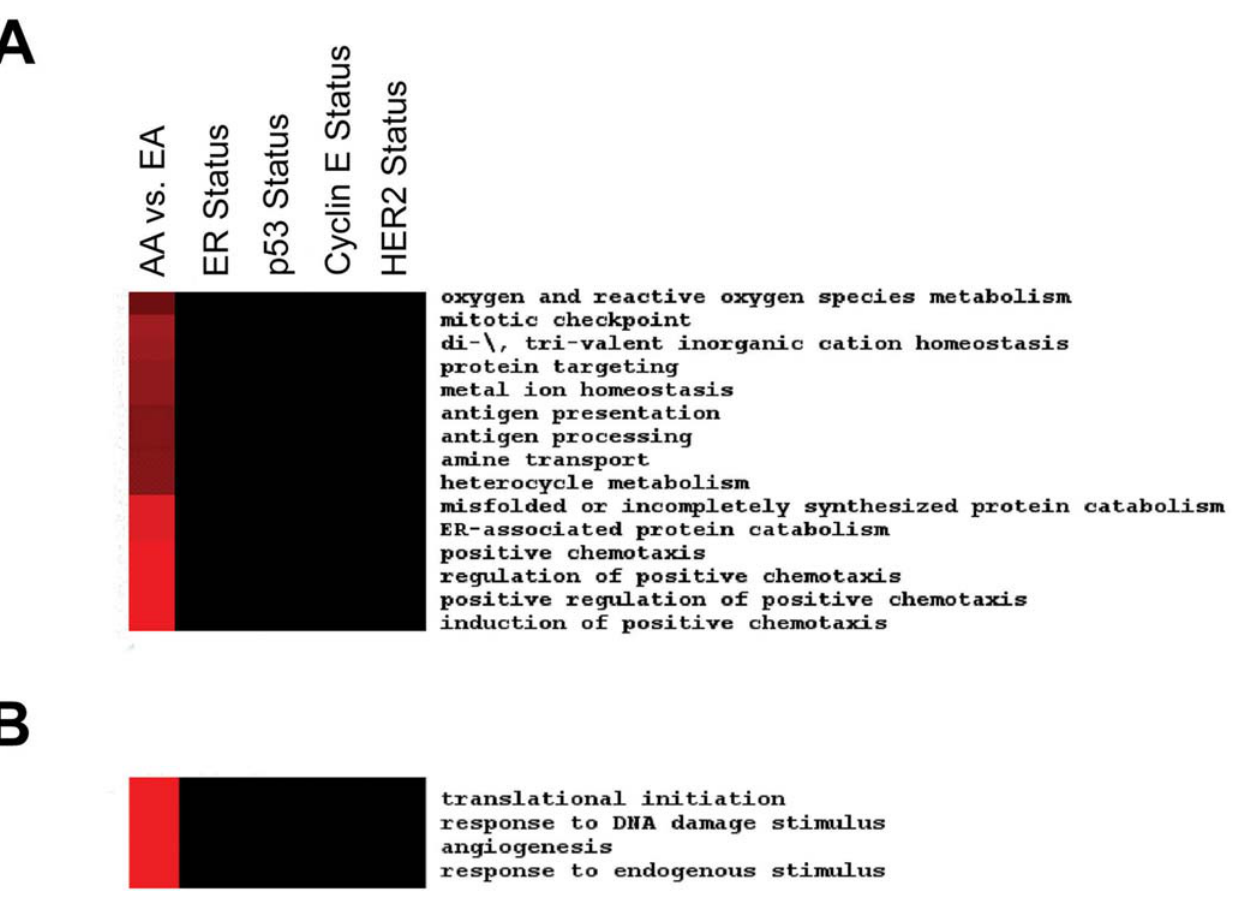
Figure 2. Uniquely enriched biological processes in the tumor epithelium (A) and tumor stroma (B) comparing African-American breast cancer patients with European-American patients. The heatmap shows that some GOBP terms, e.g., those related to endoplasmic reticulum-associated protein catabolism and positive regulation of chemotaxis in the tumor epithelium and angiogenesis in the tumor stroma, show a uniquely strong enrichment for differentially expressed genes when comparing the two patient groups. The same significant enrichments were not observed when we stratified these tumors either by ER status (negative versus positive), p53 status (negative versus positive), cyclin E status (negative versus positive), or HER2 status (positive versus negative). The color coding of the heat maps is related to the enrichment of genes in a biological process ( 2 Log( P value)-based) with red indicating a higher enrichment.